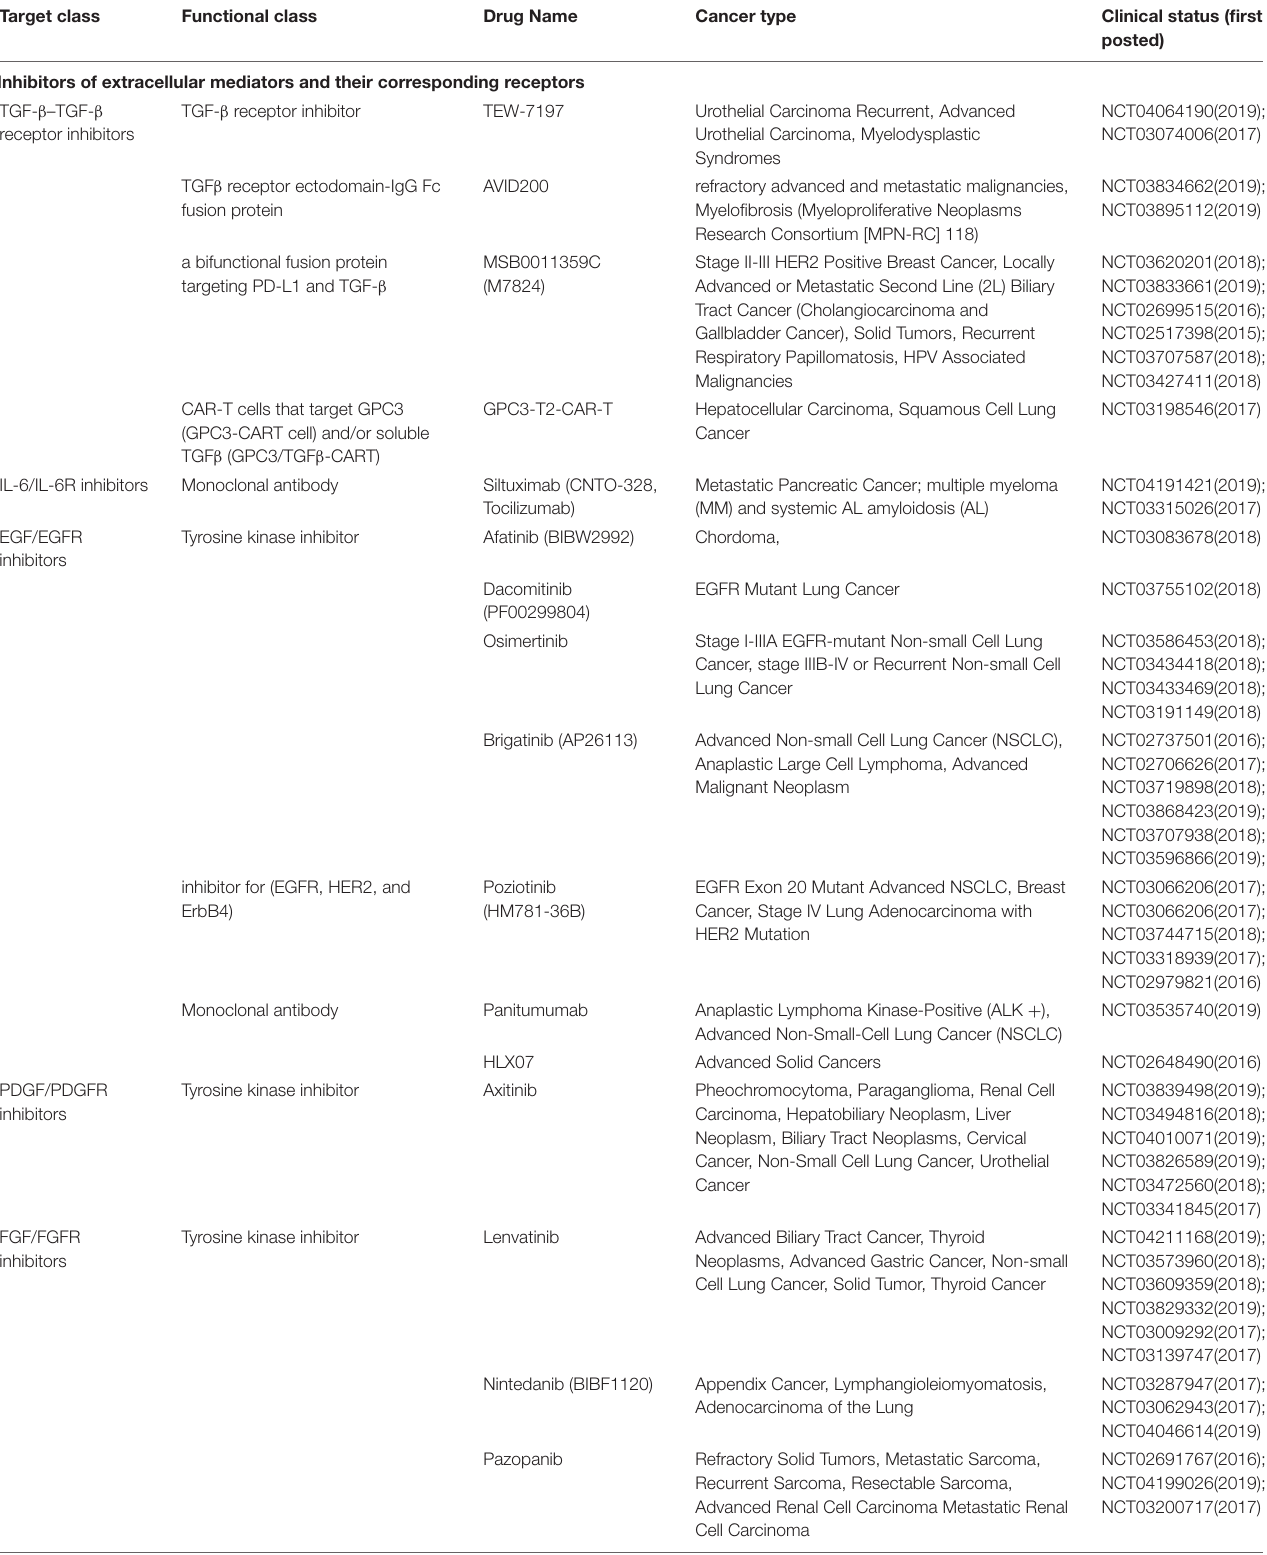
TABLE 2 | Different categories of inhibitors that target stimuli and signaling pathways associated with EMT and are targeted in current clinical